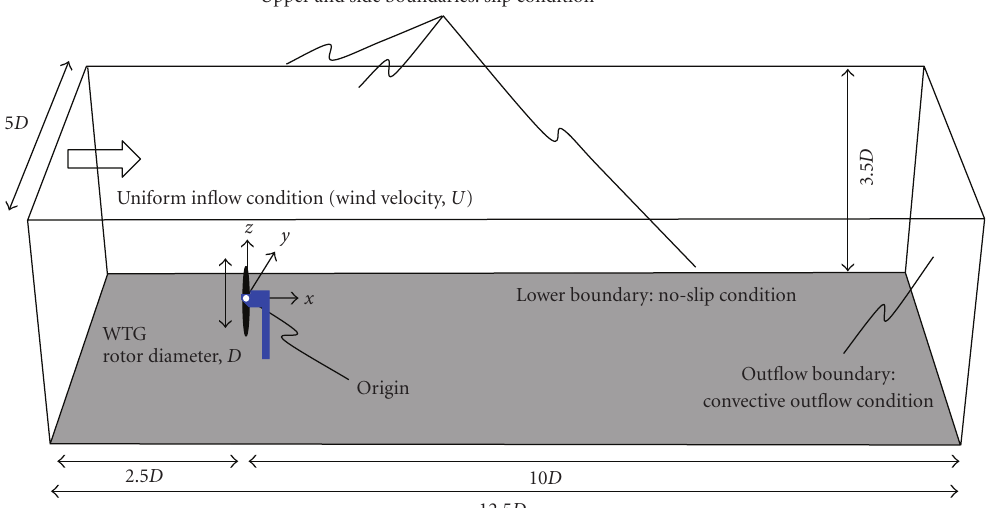
Figure 3: Computational domain and boundary conditions.